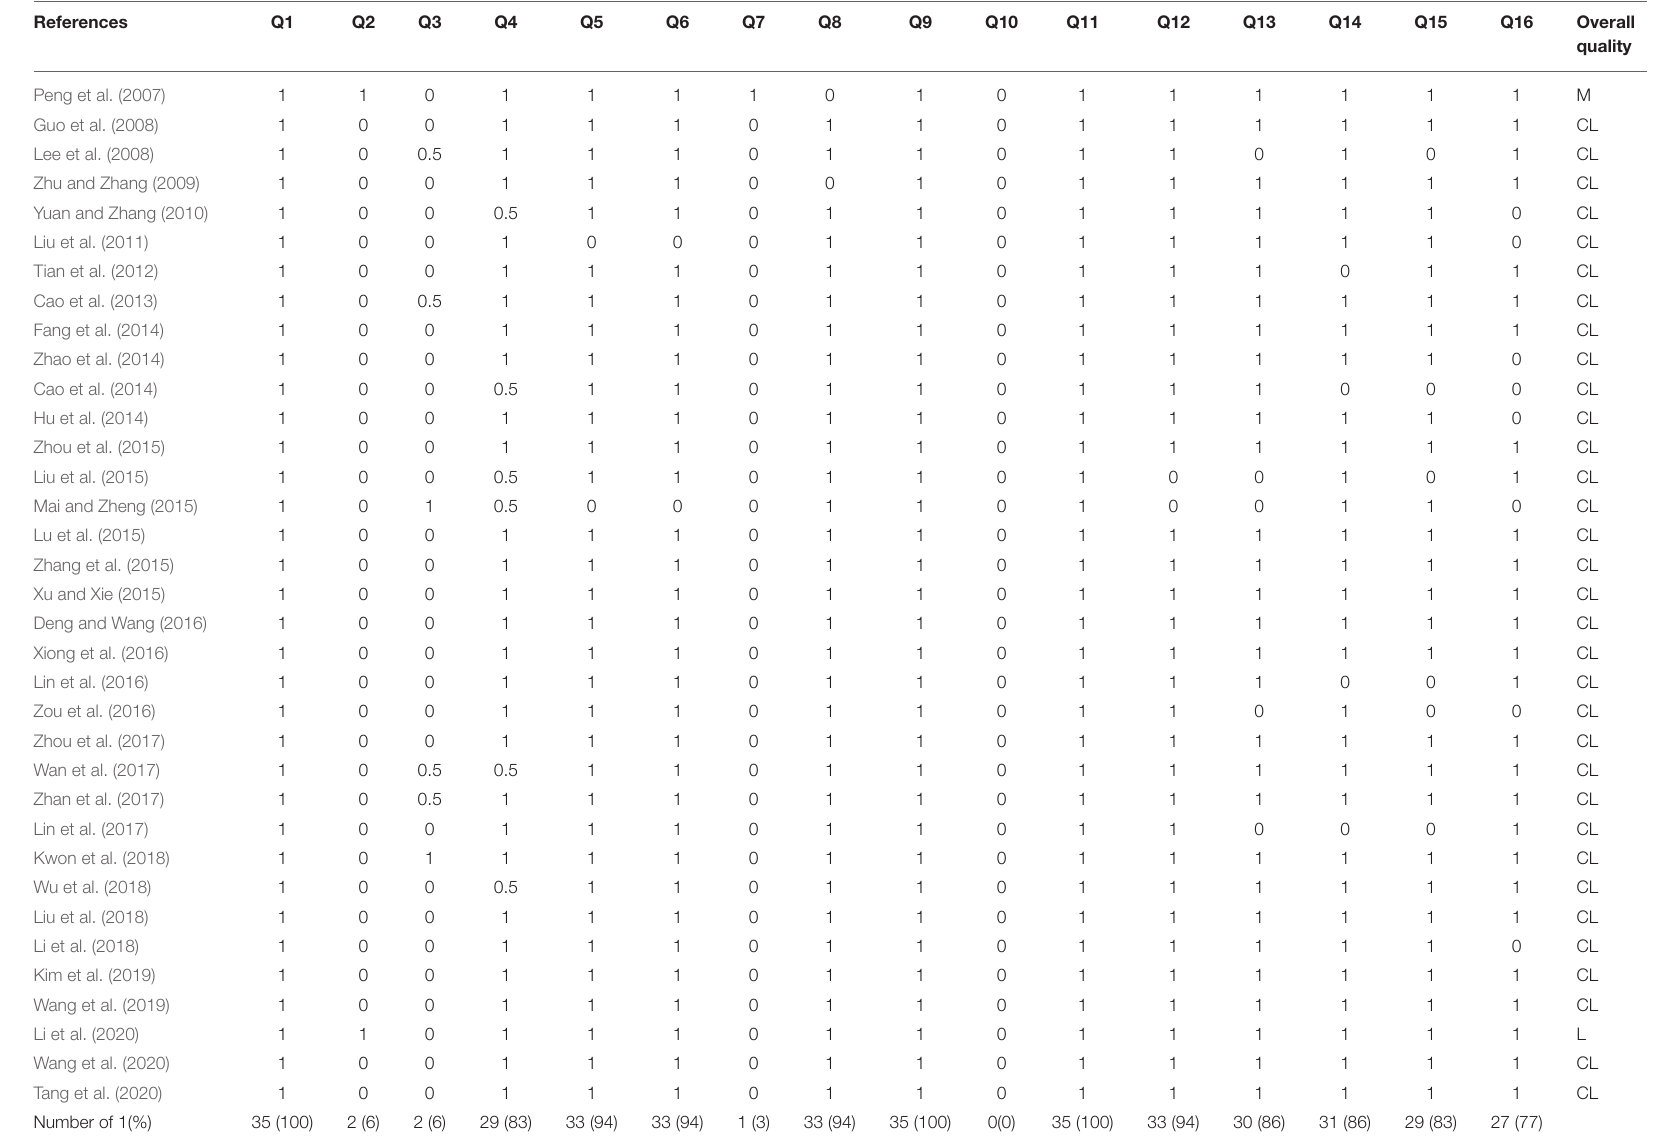
TABLE 2 | Critical appraisal of included studies using the AMSTAR-2